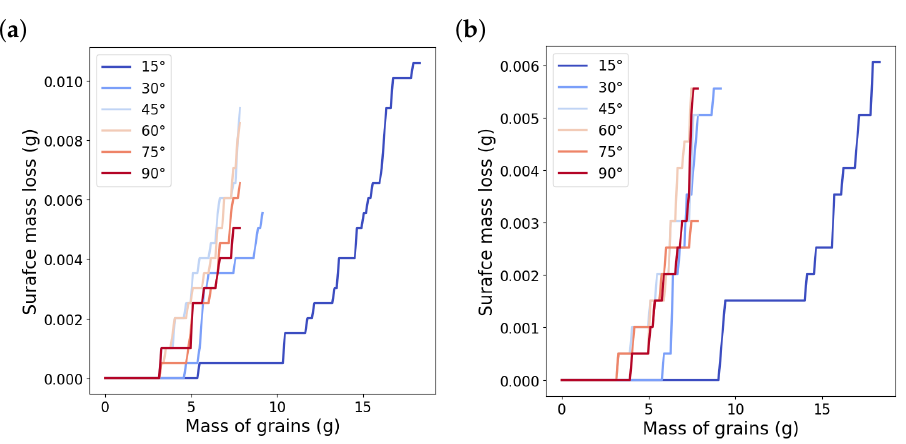
Figure 9. Mass loss development of two surface samples ( a , b ) in terms of the mass of the grains for different impact angles.